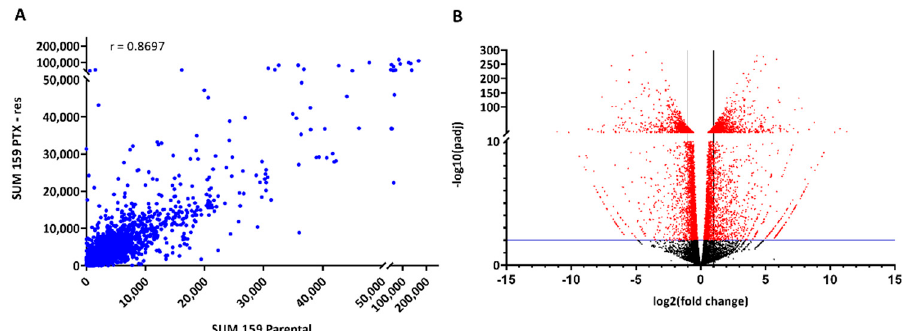
Figure 2. Transcriptomic analysis of SUM159 parental and PTX-res cells. ( A ) Scatter plot for the expression levels of the 27,967 genes analyzed by RNA-seq (presented as average number of reads). ( B ) Volcano plot ( p -value vs. log2fold change of gene expression) of the 27,967 genes that were analyzed. Differentially expressed genes (DEGs) between parental and resistant cells are depicted in red, while the blue line indicates the cut-off of statistical significance ( p -adjust value < 0.01). r: Pearson correlation coefficient.